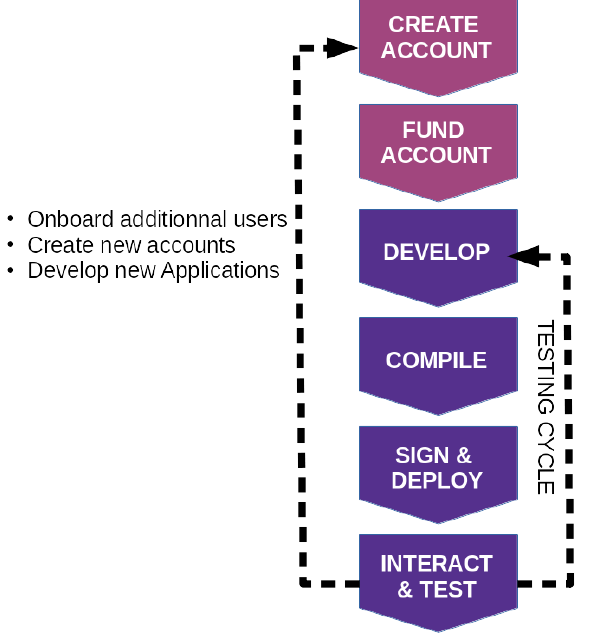
Figure 1. Blockchain development